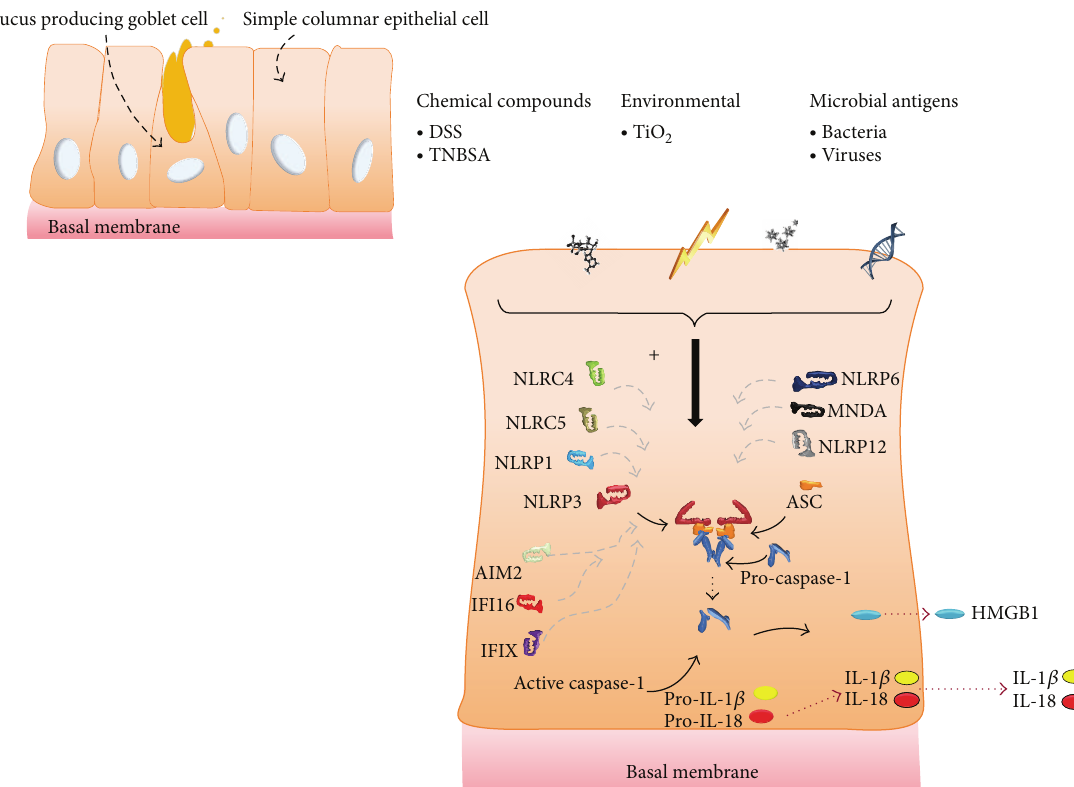
Figure 3: Schematic representations of simple columnar epithelial cells lining the digestive tract reflecting multiple inflammasomes that are described to be activated by different described agents AIM2, IFI16, MNDA, and PYHIN1 are subtypes of the non-NLR inflammasome